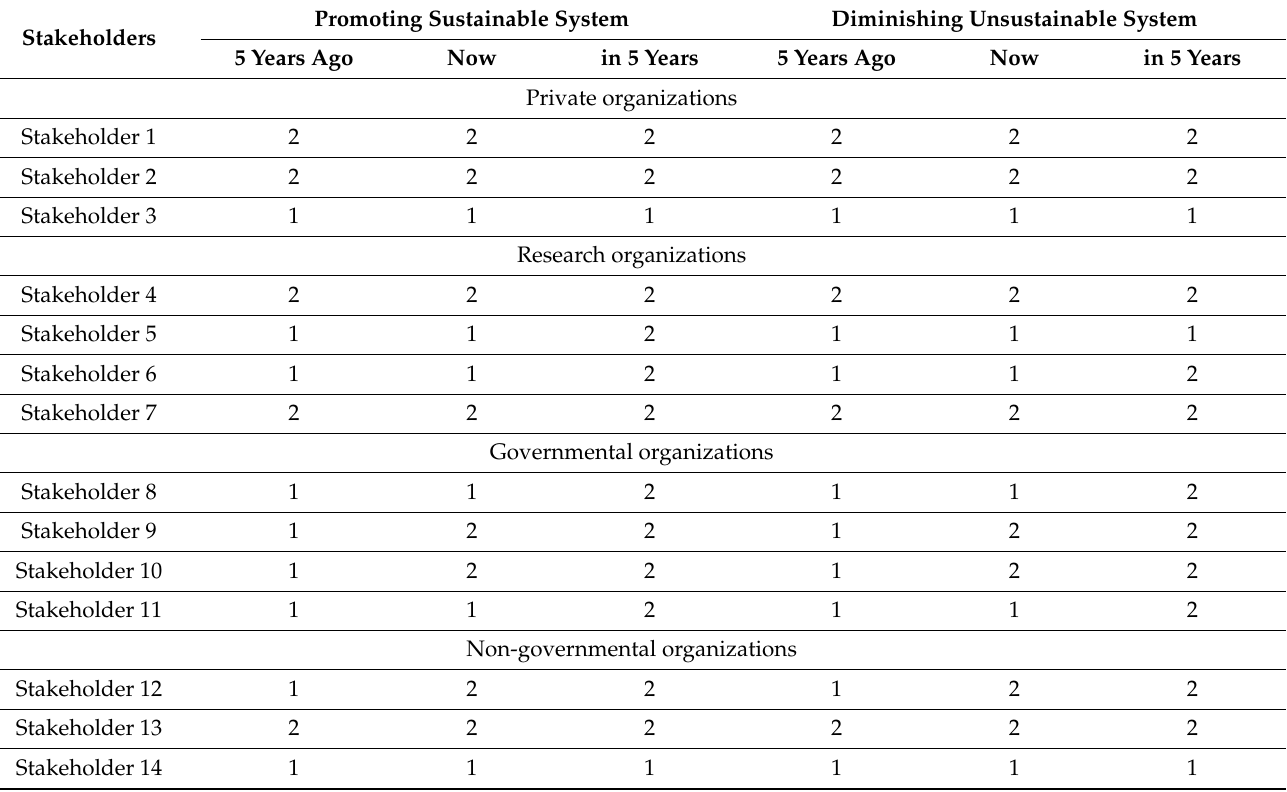
Table 4. Stakeholders’ relevance to GT for biogas production from manure and agro wastes in